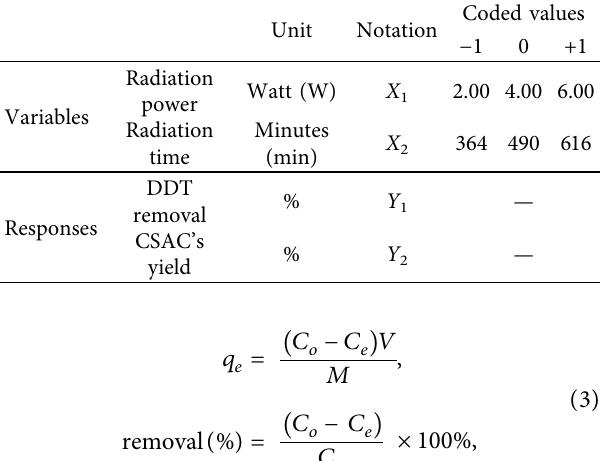
Table 1: Experimental variables and